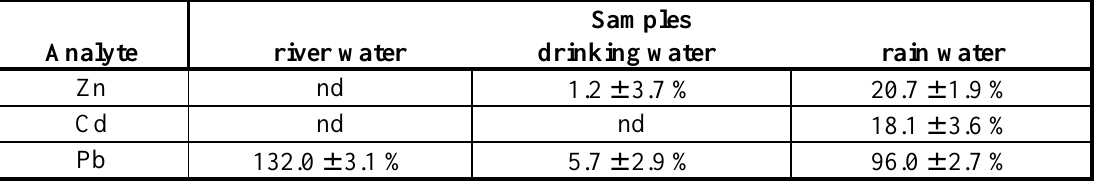
Table 3. Determination of trace metals ( µ g L -1 ) in water samples a